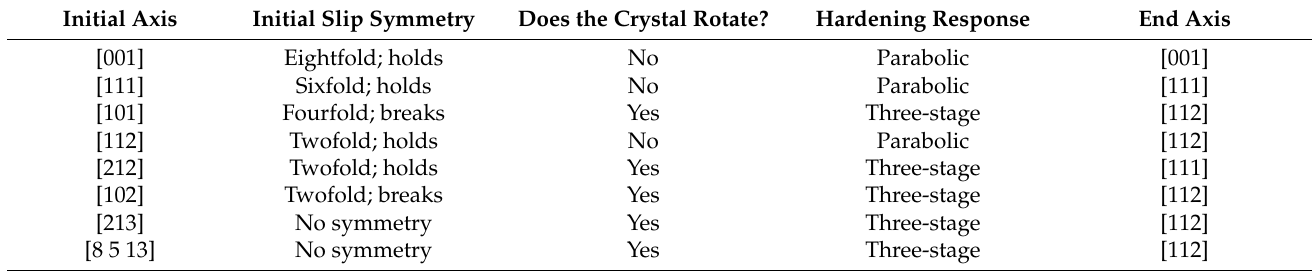
Figure 2. ( a ) The stress–strain curves of single crystal aluminum with initial orientations of [001], [111], [112], [101], [102] and [213], as obtained by the MD simulations [23]; ( b ) the corresponding experimental stress–strain curves, as obtained from tensile straining tests using single crystal copper [14]. The qualitative characteristics of strain hardening that were observed in the MD simulations